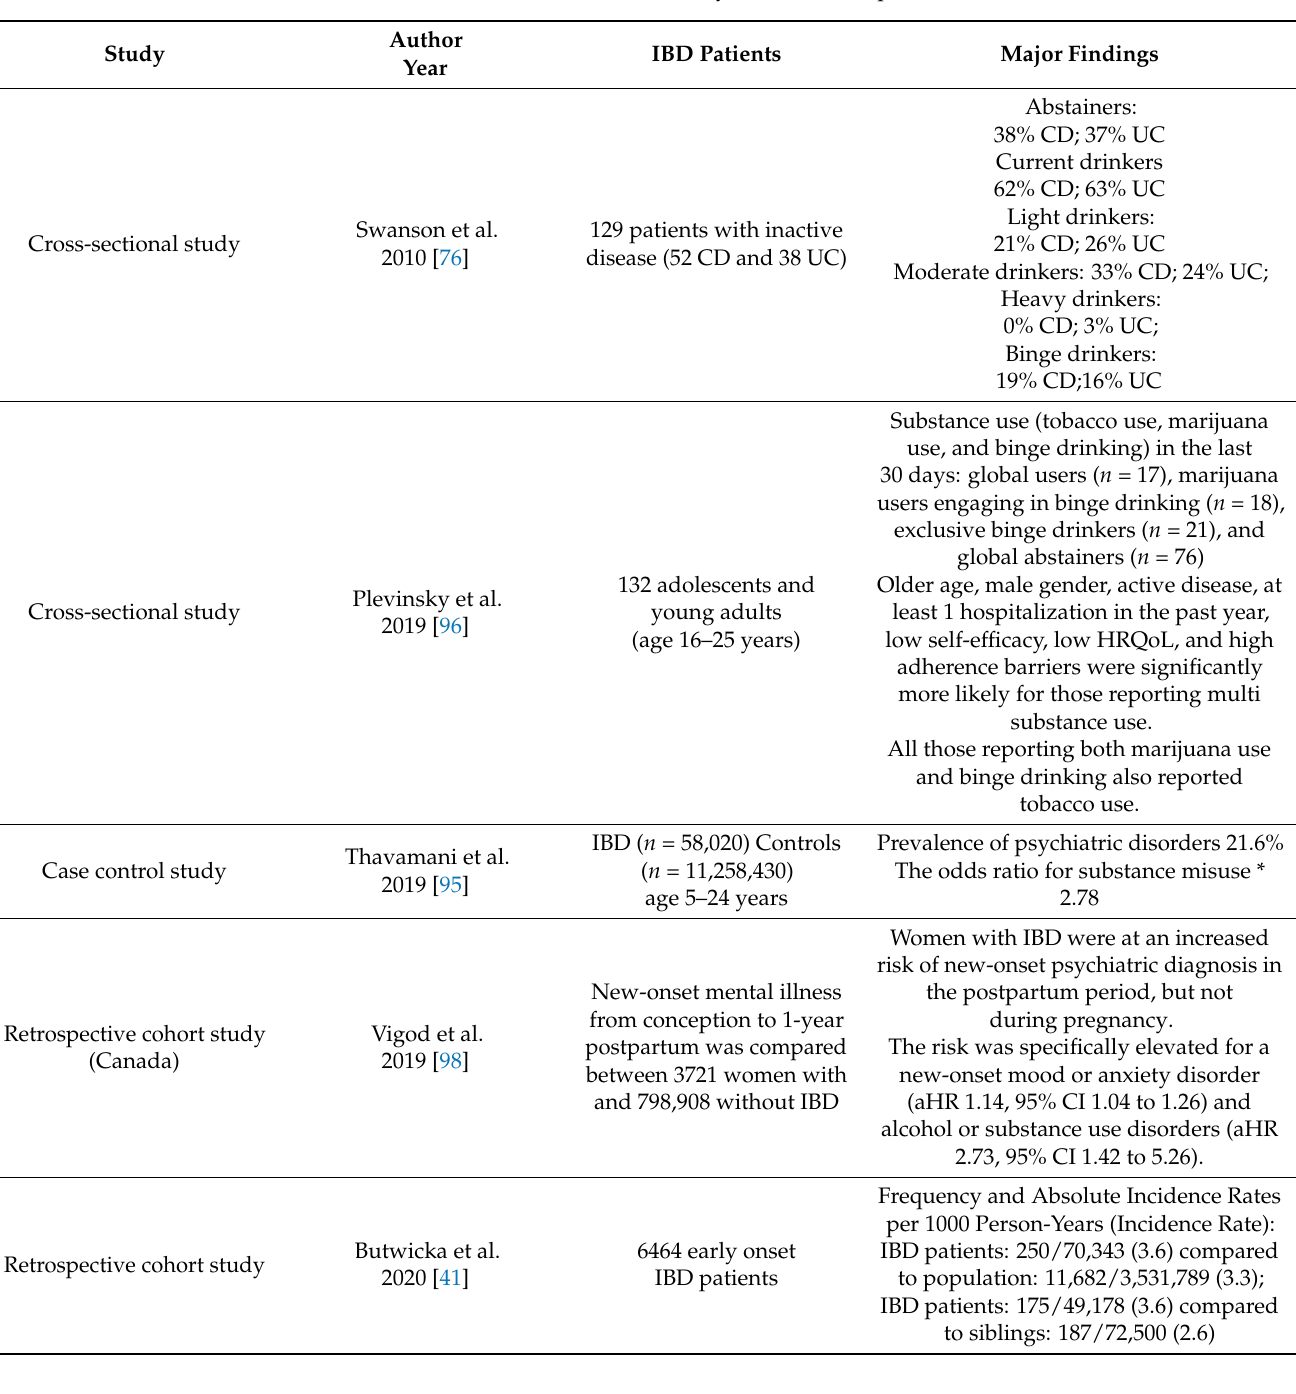
Table 5. Alcohol misuse in inflammatory bowel disease